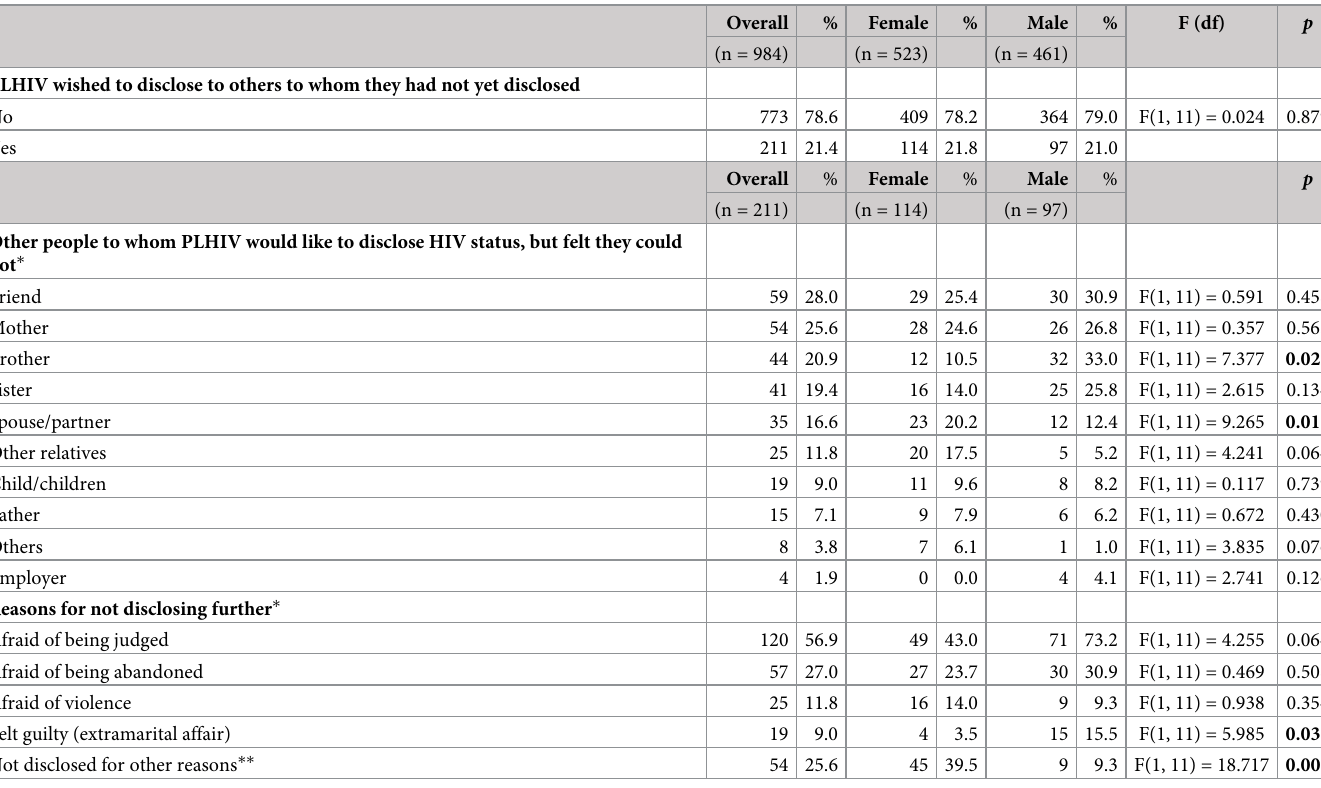
Table 2. Patterns of HIV disclosure among PLHIV who have already disclosed HIV status, by sex and adjusted for community clustering.